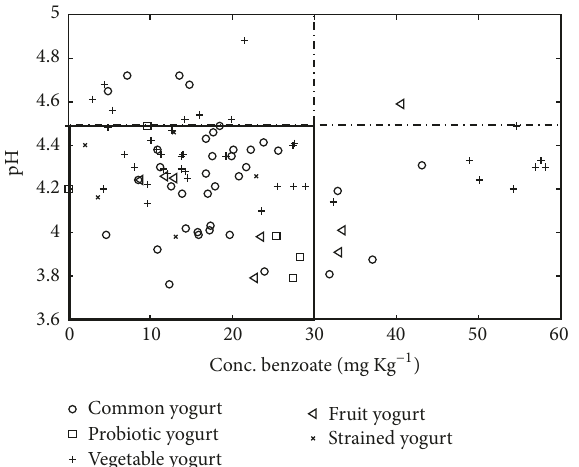
Figure 7: Illustration of concentration content of sorbate in the yogurt